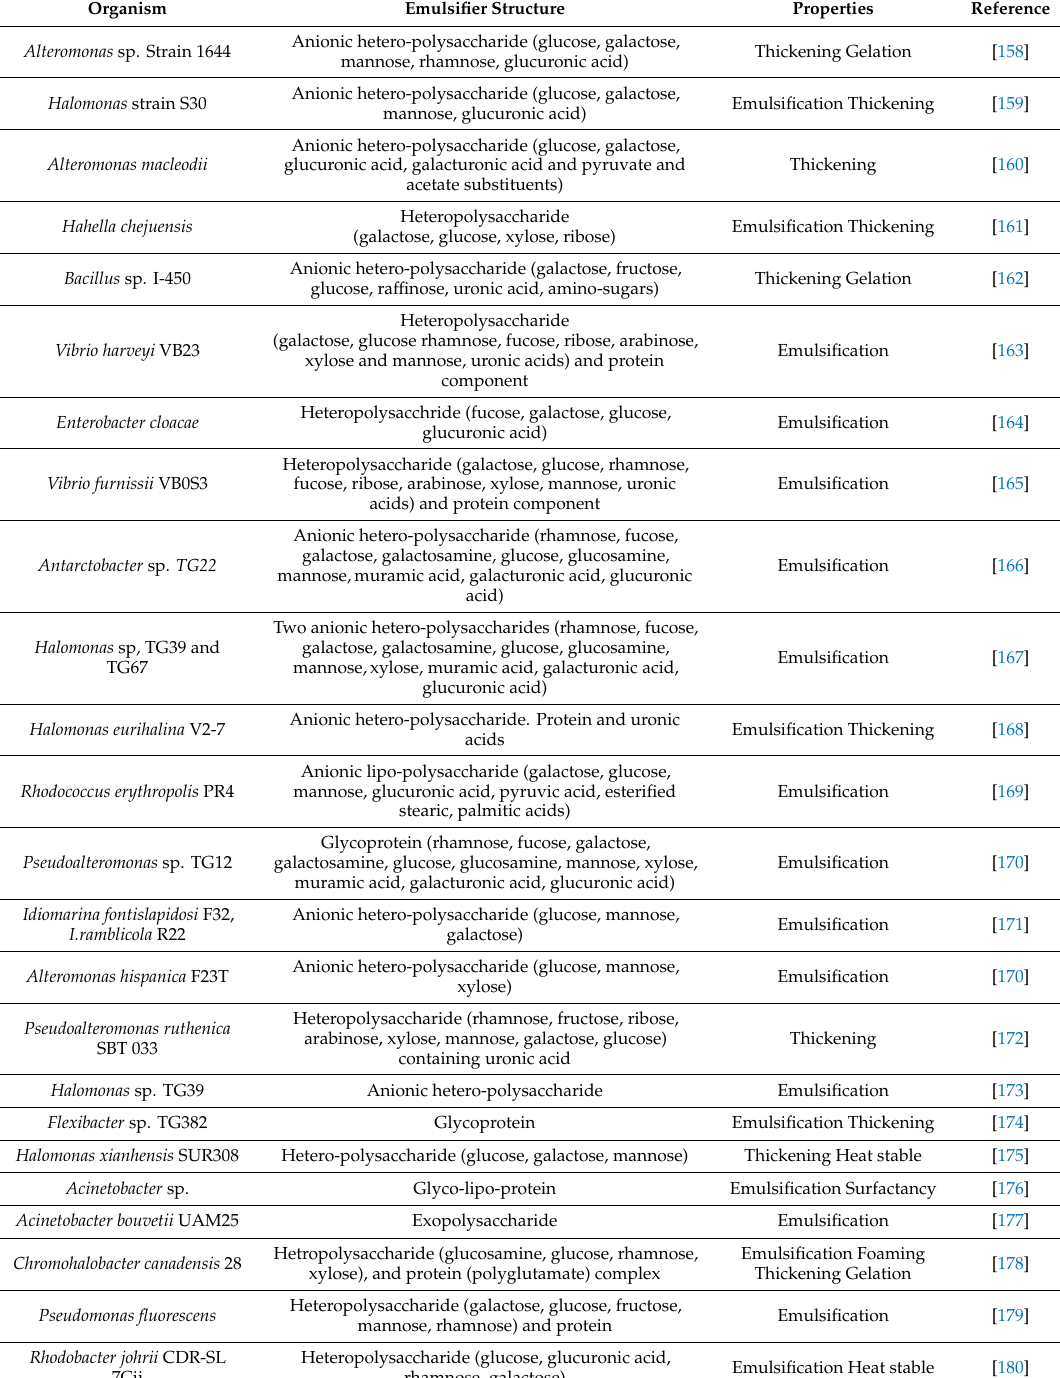
Table 2. Marine bacteria reported to produce bio-emulsifiers of interest to food